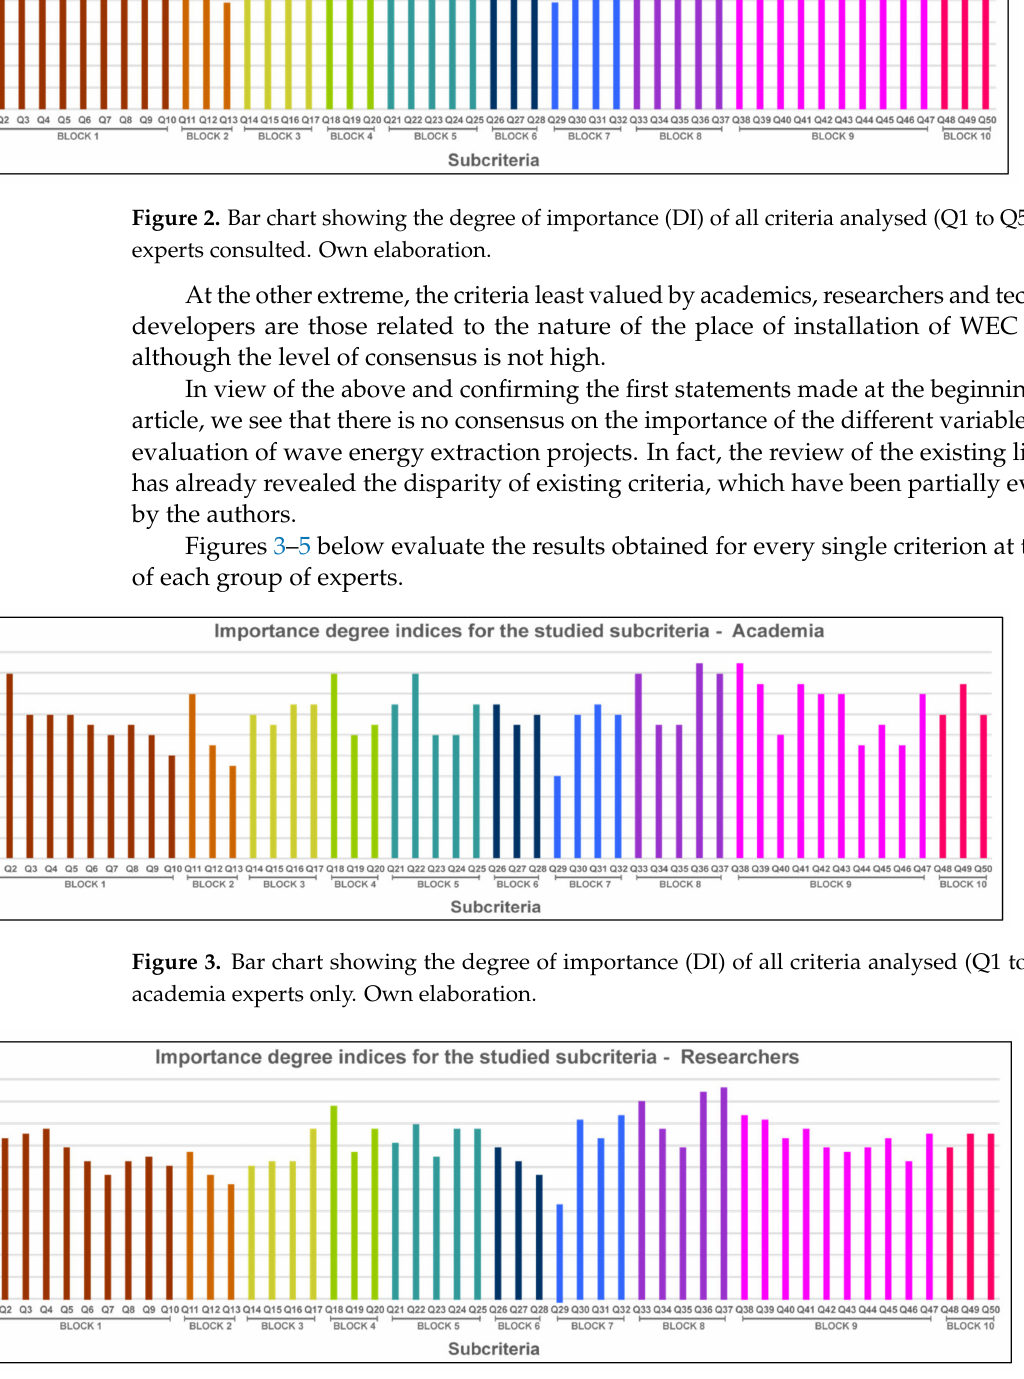
Figure 4. Bar chart showing the degree of importance (DI) of all criteria analysed (Q1 to Q50) by the research experts only. Own